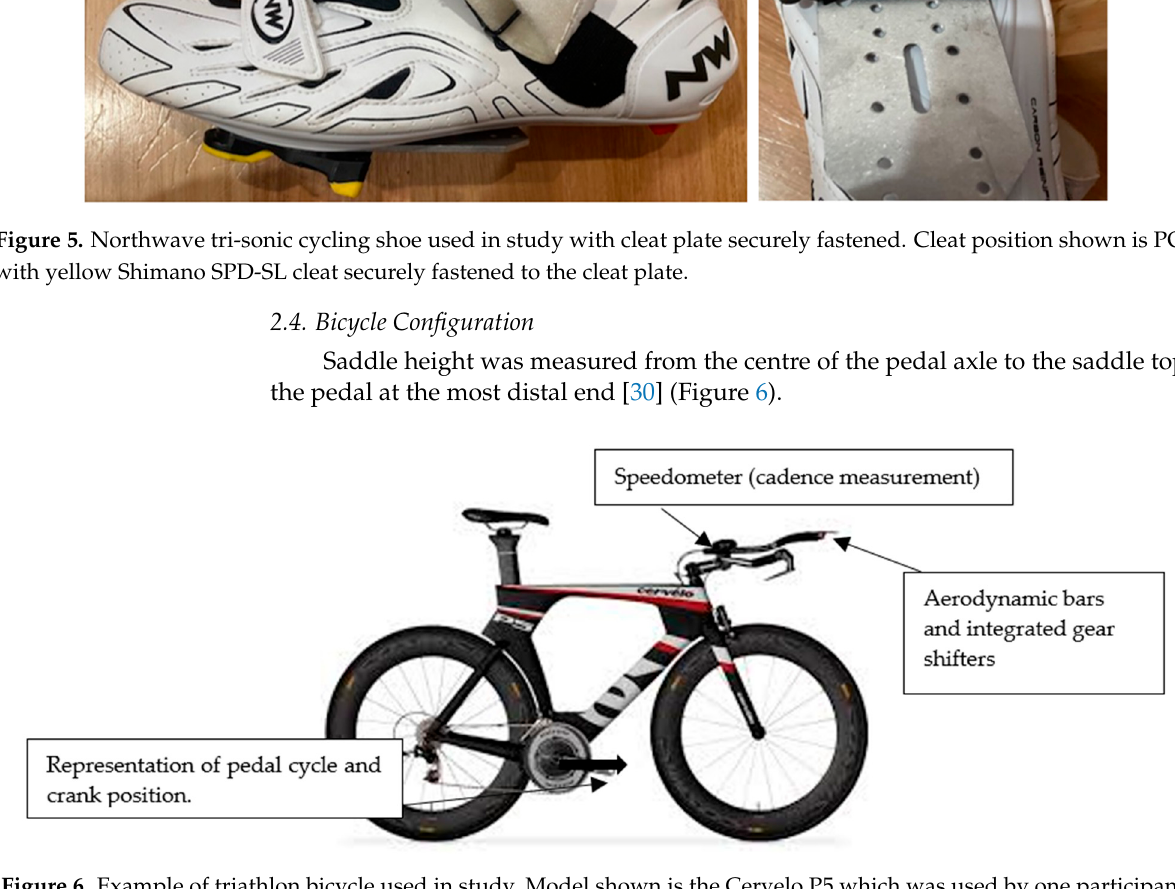
Figure 6. Example of triathlon bicycle used in study. Model shown is the Cervelo P5 which was used by one participant.